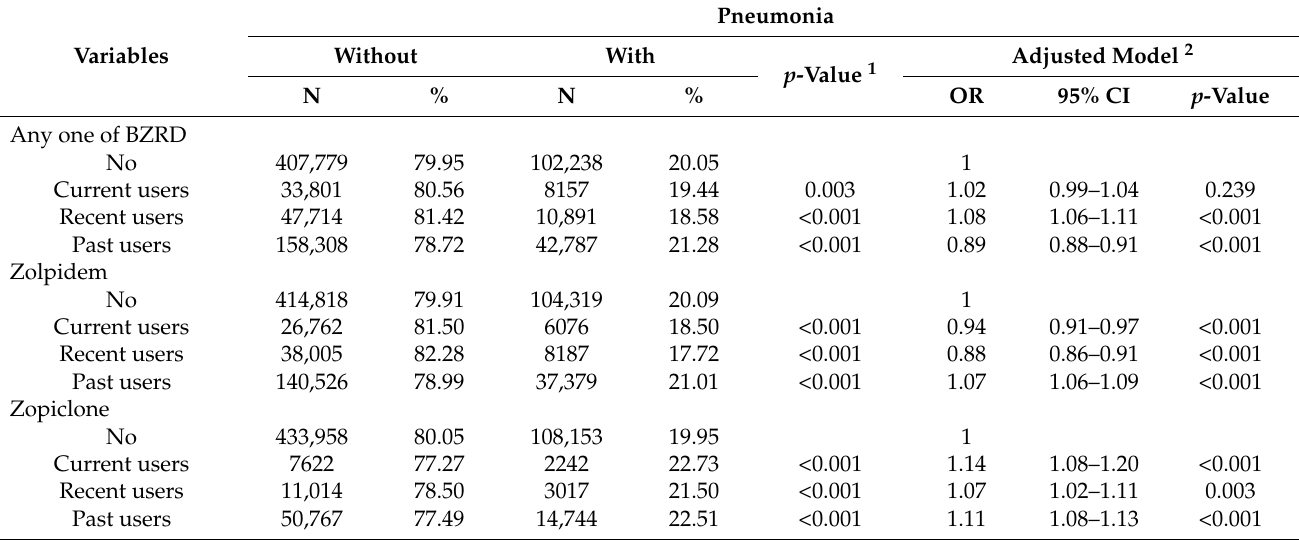
Table 3. Pneumonia risk associated with benzodiazepine related drugs